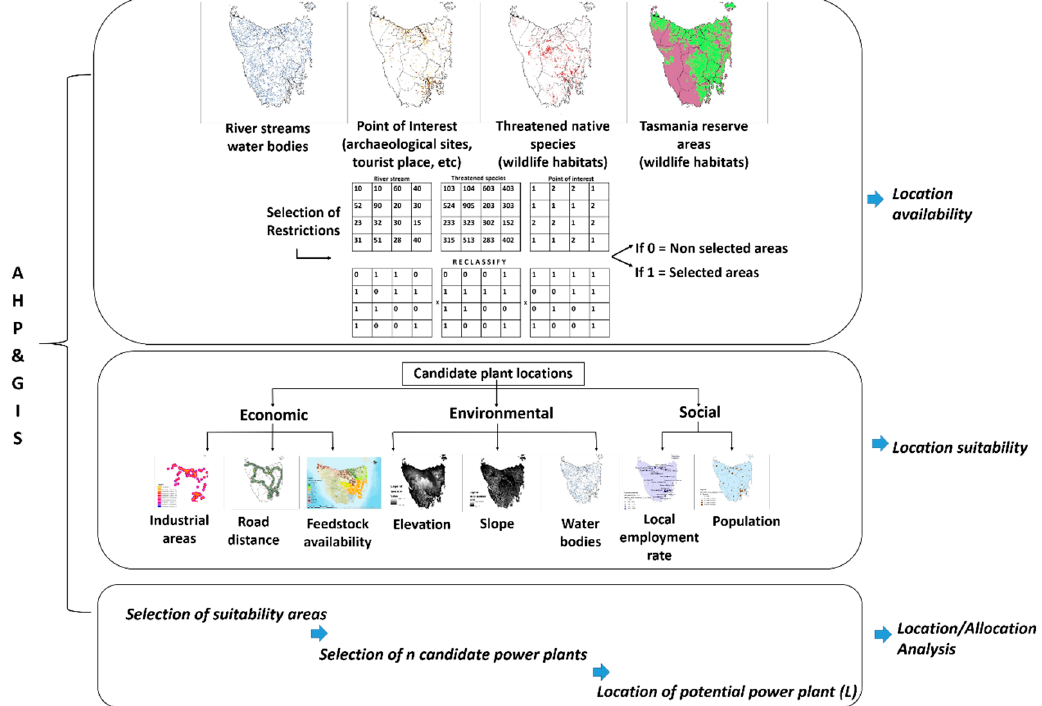
Figure 1. The overall approach to determine optimal locations of biomass facilities.